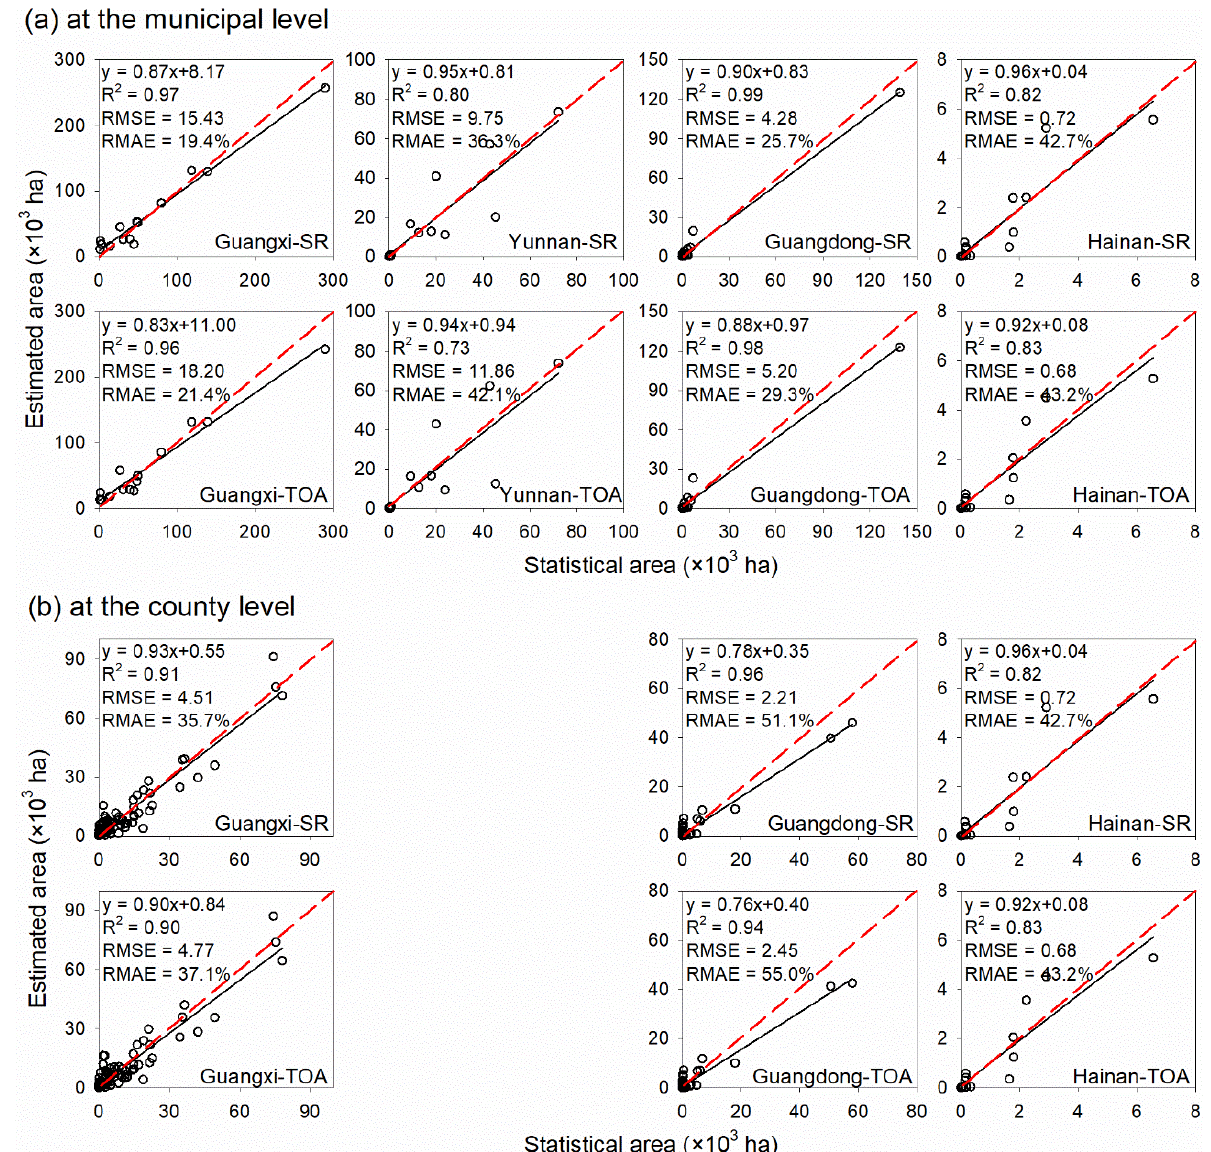
Figure 8. Correlations between the estimated and agricultural statistical planted areas of sugarcane at the ( a ) municipal and ( b ) county level in China for each province in 2019.